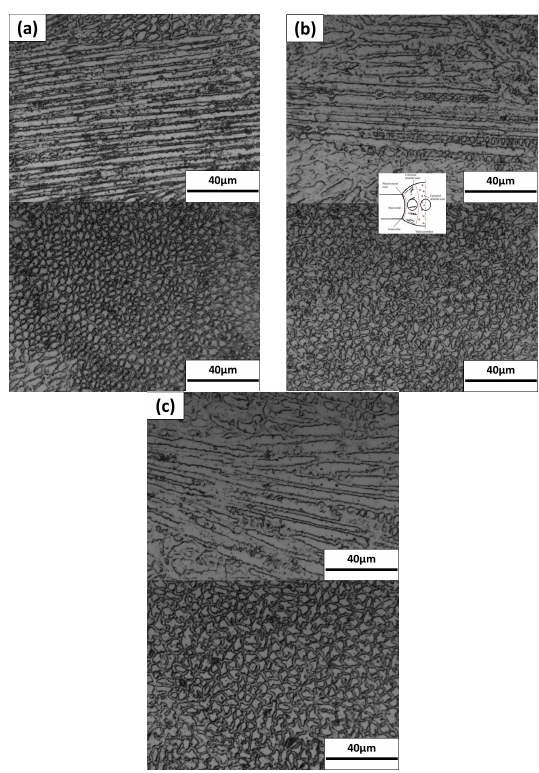
Figure 11. Variations of grain size with pulse duration: ( a ) τ = 4 ms; ( b ) τ = 6 ms; ( c ) τ = 8 ms.